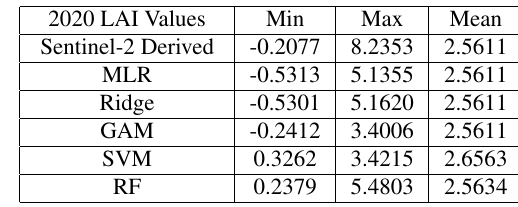
Table 2. Derived and predicted LAI values for each model in